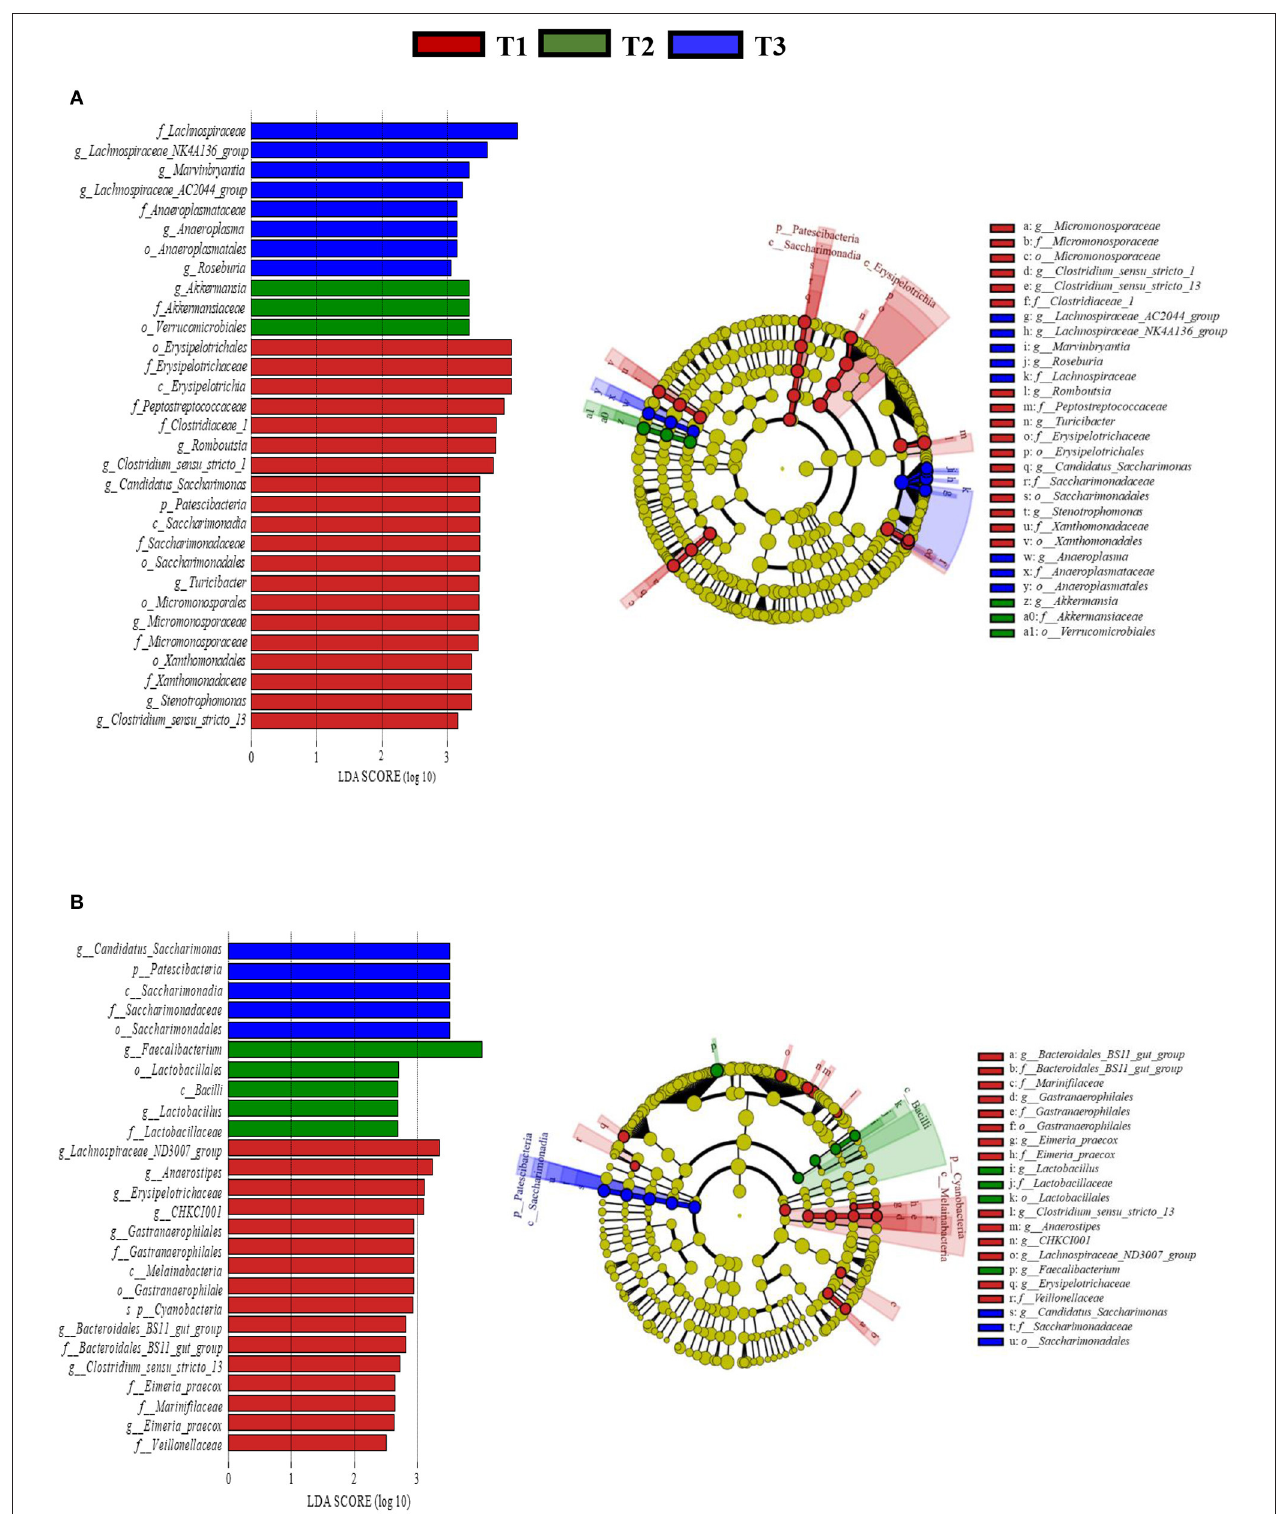
FIGURE 6 | Linear discriminant analysis (LDA) effect size (LEfSe) analysis identified the most differentially abundant from phylum to genus in the cecal mucosa (A) and digesta (B) between T1 (red), T2 (Green), and T3 (Blue) groups. The genus with linear discriminant analysis values higher than 2.5 is displayed. The length of the bar column represents the LDA score. The cladogram, circles radiating from inner side to outer side represents the differences in the relative abundance of taxa from phylum to genus level between the three groups. T1 (normal corn 100%, high amylose corn 0%); T2 (normal corn 50%, high amylose corn 50%); T3 (normal corn 0%, high amylose corn